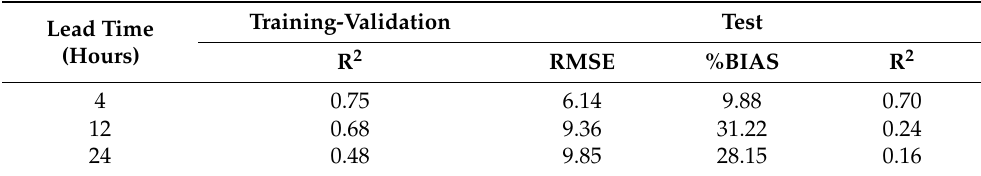
Figure 6. 12-h forecast model performance (R 2 ) for different combinations of max_depth and max_features for 3 cases of n_estimators (number of trees): ( a ) 10, ( b ) 50, and ( c ) 200. Table 3. Performance of the 4-, 12-, and 24-h runoff Random Forest (RF) models by using default hyperparameters and the test